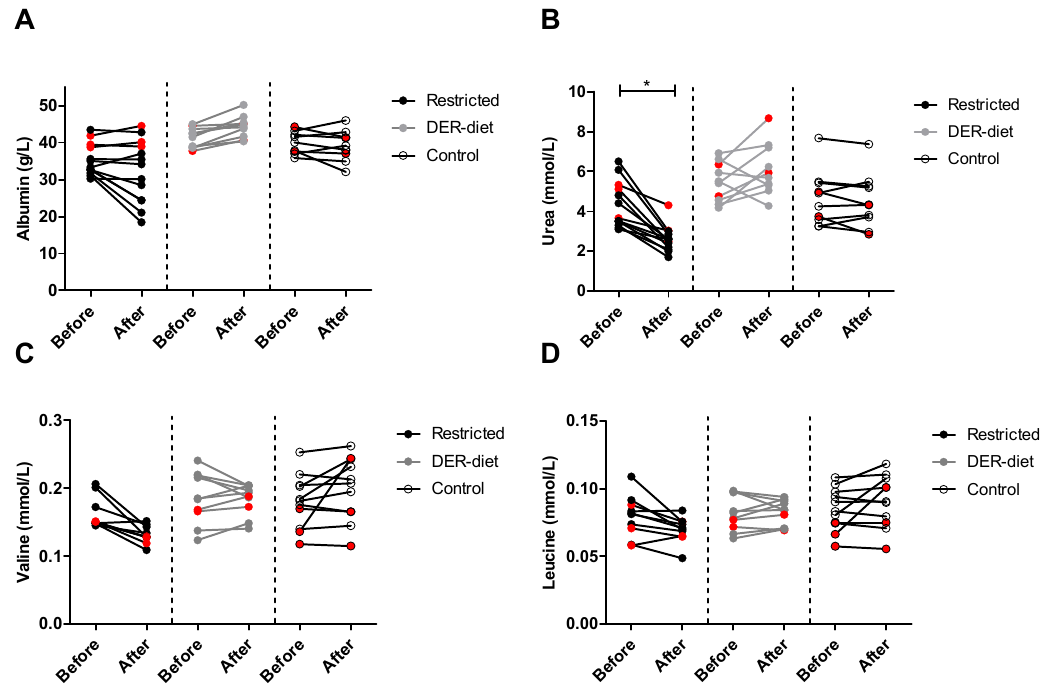
Figure 4. Serum levels of albumin, urea, valine and leucine after the three dietary interventions. ( A ) Serum albumin did not significantly change in any of the groups; ( B ) serum urea was decreased significantly after the restricted diet, while it did not change after the DER diet or in the control group; both serum valine ( C ) and leucine ( D ) did not differ between groups, but did show a trend towards a decrease after the restricted diet; red symbols = kidney donors, as opposed to morbidly obese individuals (black or gray symbols); DER = daily energy requirements.